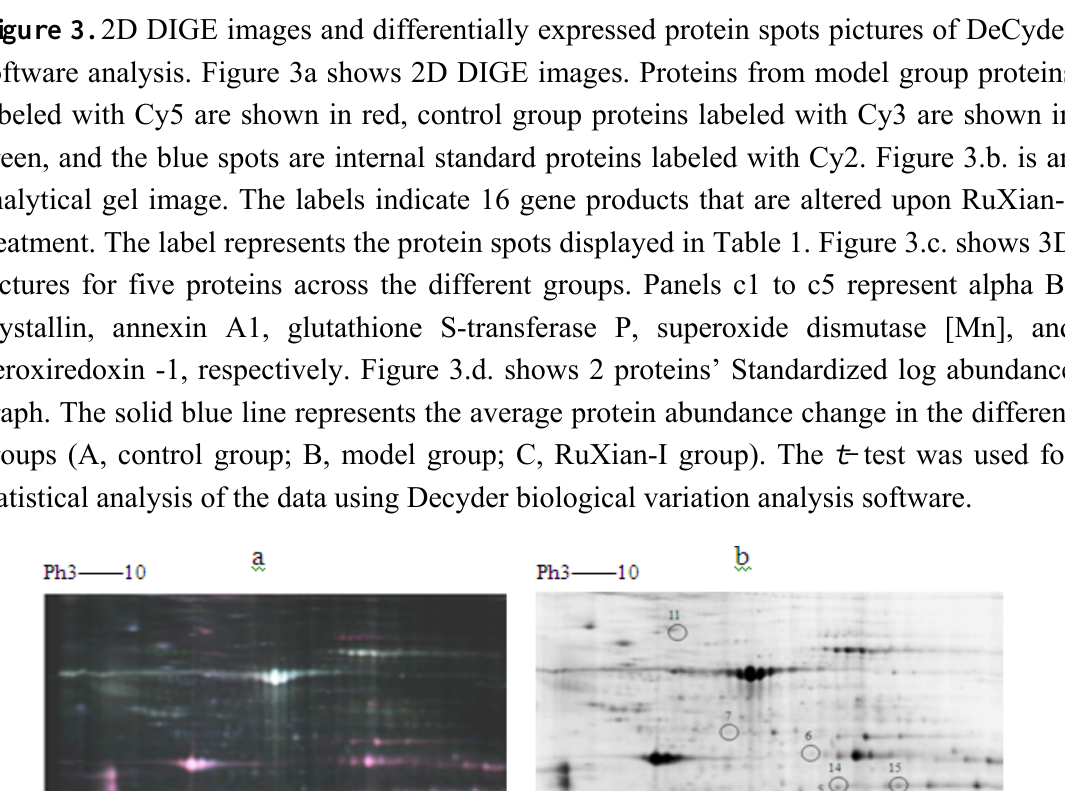
Figure 3. 2D DIGE images and differentially expressed protein spots pictures of